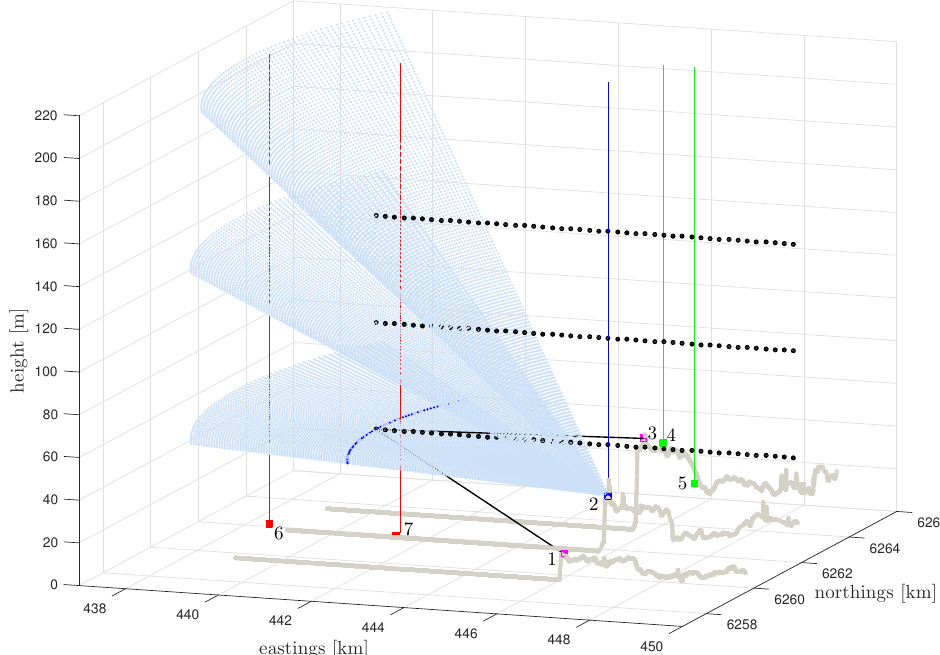
Figure 4. Overview of the scanning strategies during phases 2 and 3. Collocated points from the dual setup are shown in black circles and the two black lines show two laser beams focusing in position 7. The points from the PPI scans are denoted with light blue points and dark blue points denote the first 60 ◦ scan that is collocated with the first dual setup point at 50 m ASL. The vertical coloured lines denote the positions of the profiling lidars and the grey lines denote the terrain height at the northing locations of positions